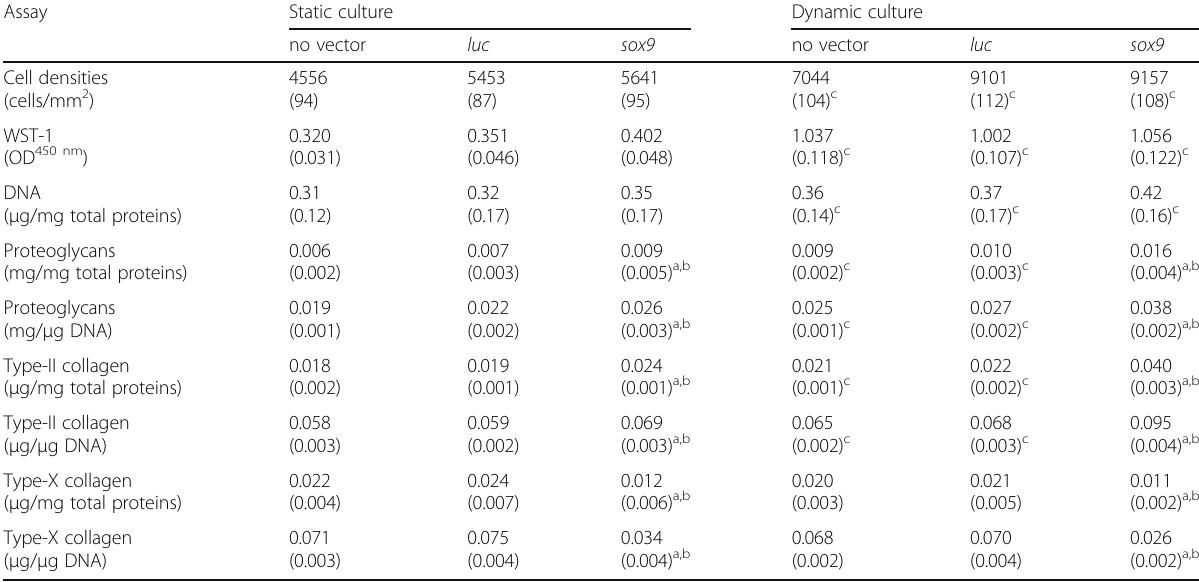
Table 1 Biochemical assays in the rAAV-transduced human bone marrow aspirates (day 21) Assay Static culture Dynamic culture no vector luc sox9 no vector luc sox9 Cell densities (cells/mm 2